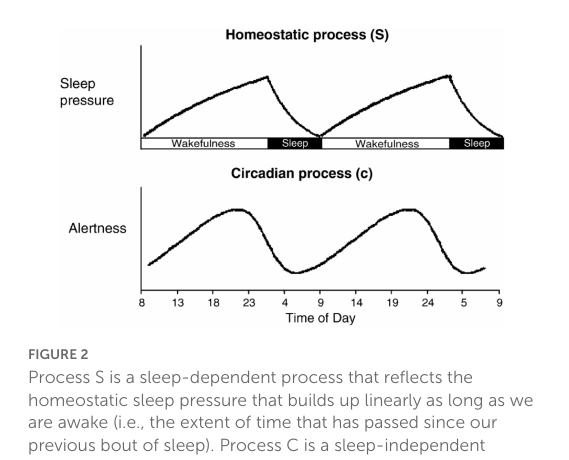
FIGURE2 Process S is a sleep-dependent process that reflects the homeostatic sleep pressure that builds up linearly as long as we are awake (i.e., the extent of time that has passed since our previous bout of sleep). Process C is a sleep-independent process that reflects our internal daily rhythms kept in sync with the Earth’s near 24-h cycle through the suprachiasmatic nucleus (SCN). Adapted from Stiller and Postolache